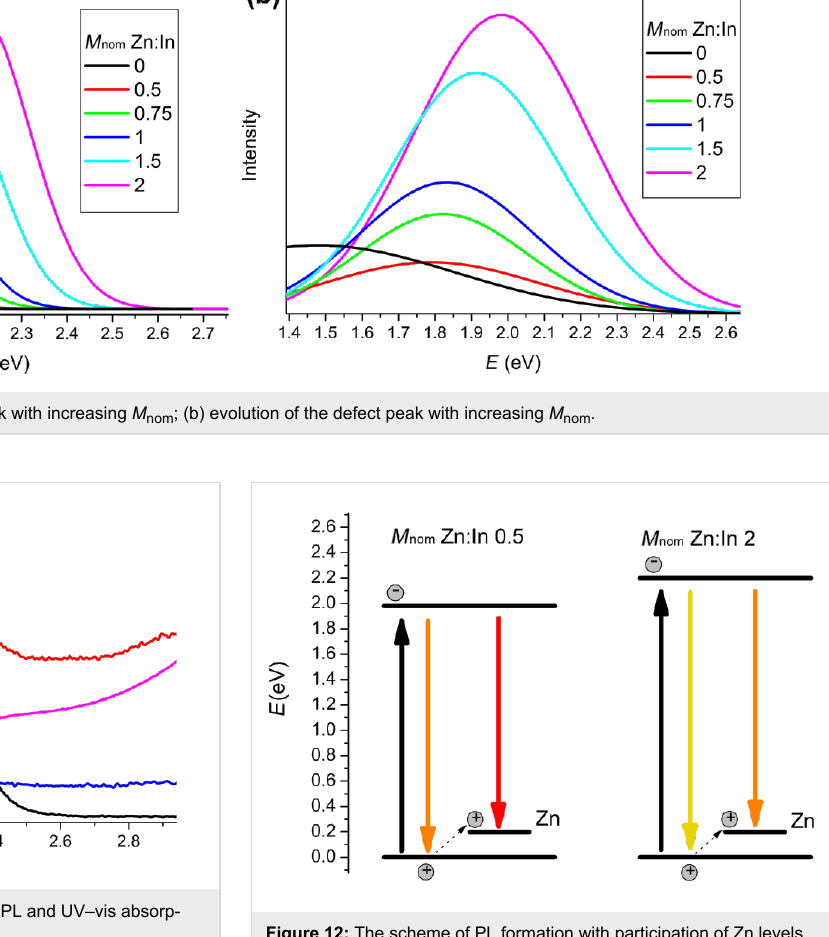
without excitonic luminescence as well as the fact that the both types of peaks are shifted together and the distance between them is constant could be explained through the doping scheme in Figure 12. This scheme solely depends on the assumption